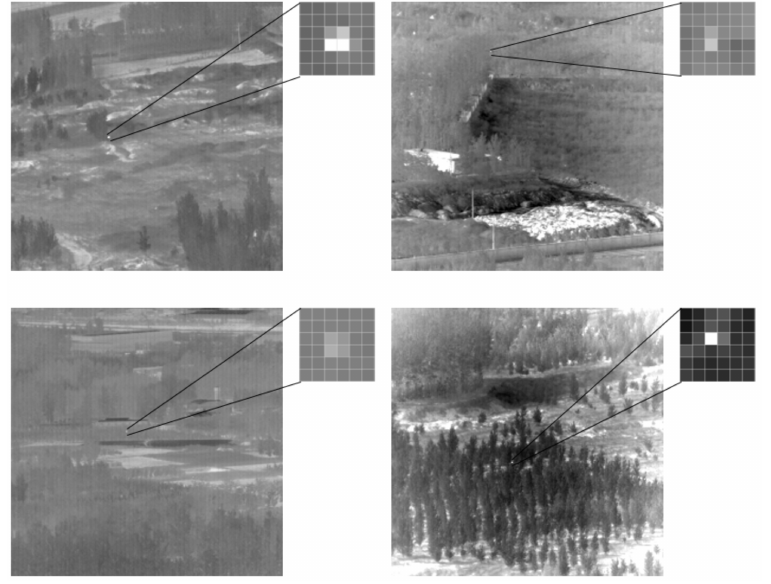
Figure 7. Infrared small target